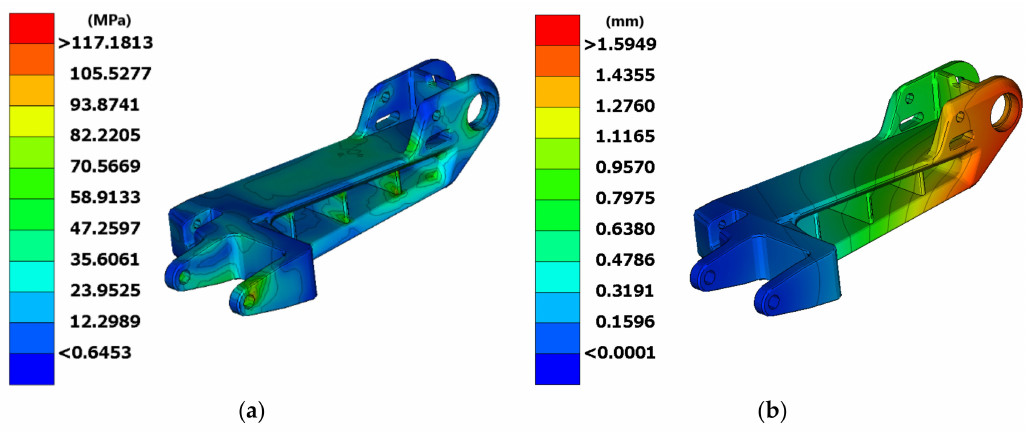
Figure 14. Stress ( a ) and displacement ( b ) results in 2nd loading scenario for the final swingarm